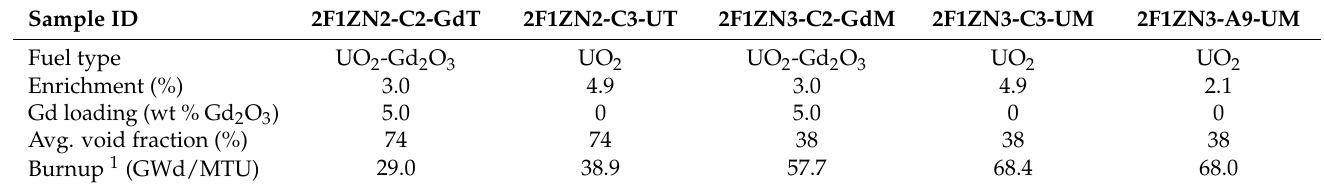
Table 1. Fuel samples main characteristics [7,8].